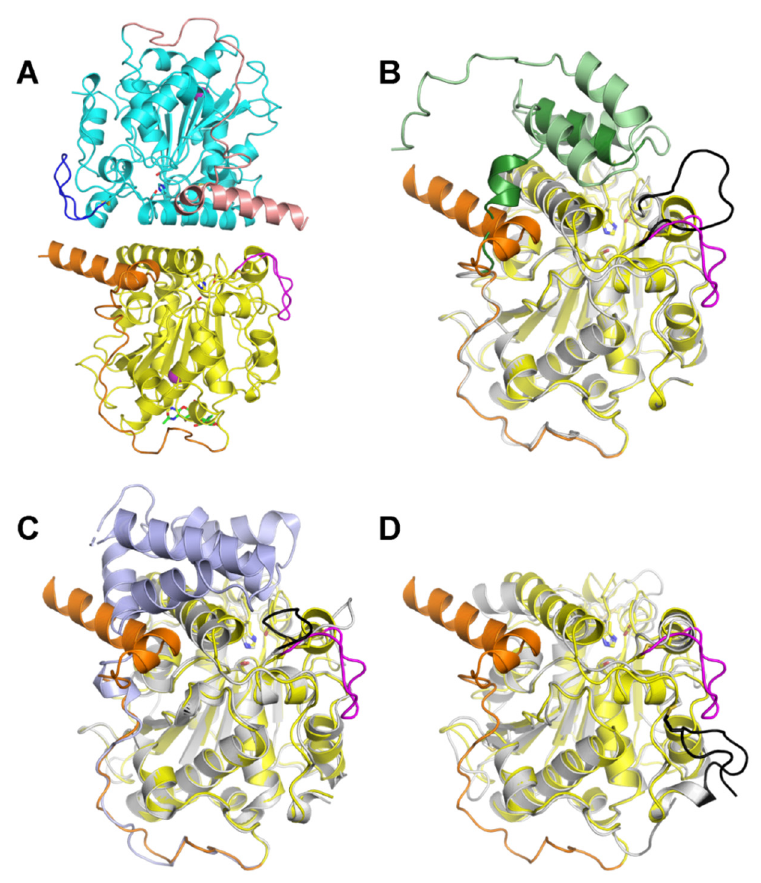
Figure 6. Structures of LTL1 and its closest homologs. ( A ) X-ray structure of LTL1. The two polypeptide chains in the asymmetric unit are coloured differently for chain A (core: yellow, N-terminal extension: orange; inserted loop: magenta) and chain B (core: cyan, N-terminal extension: pink, inserted loop: blue). Sticks are shown to highlight catalytic triads (same colour as the cores) and glycans (green). ( B ) Comparison between LTL1’s X-ray structure (chain A, presented as in A) and an AlphaFold2-predicted model (core: grey, N-terminal subdomain: green, inserted loop: black) that includes both the resolved (83–109, dark green) and unresolved residues (19–82, light green) of LTL1. ( C ) Superimposed structures of LTL1 (chain A, presented as in A) and AFLB (PDB ID: 6IDY, core: grey, N-terminal subdomain: slate, inserted loop: black). ( D ) Superimposed structures of LTL1 (chain A, presented as in A) and CALB (PDB ID: 5A71, core: grey, C-terminal extension: black).